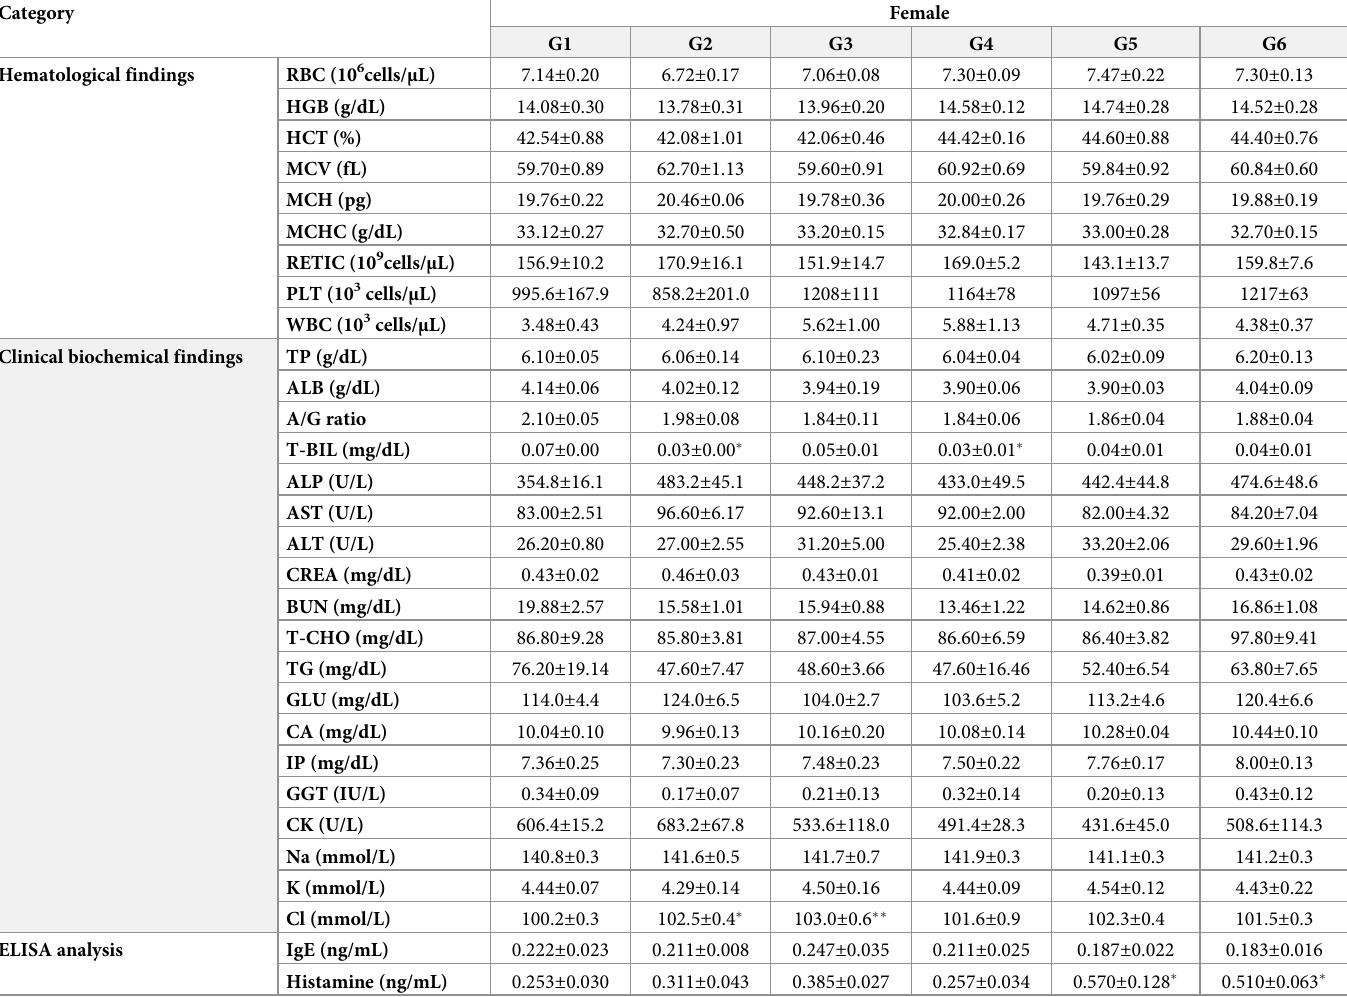
Table 3. Hematology, clinical biochemistry, and serum IgE and histamine levels in female Sprague-Dawley (SD) rats. Category Hematological